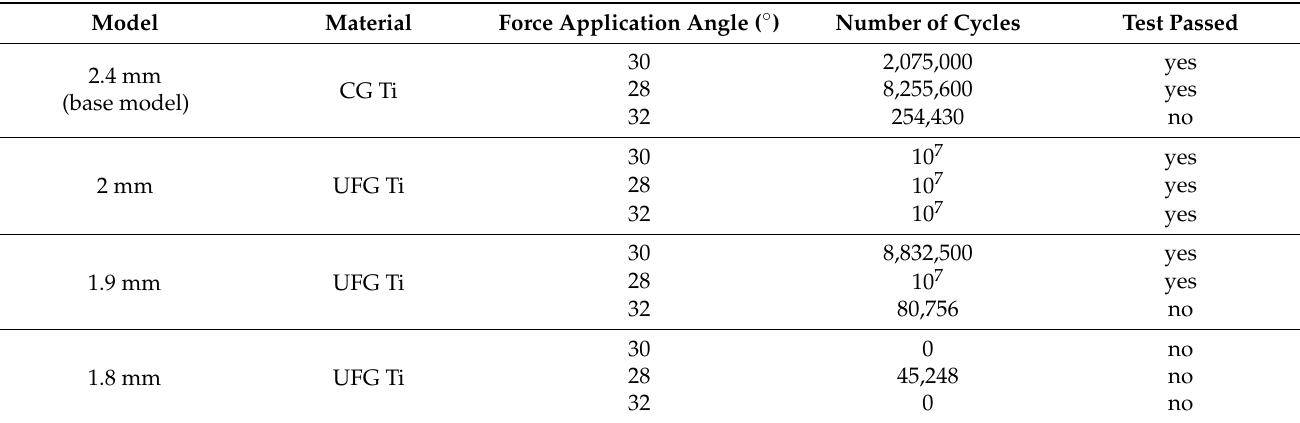
Table 2. Results of virtual fatigue tests.